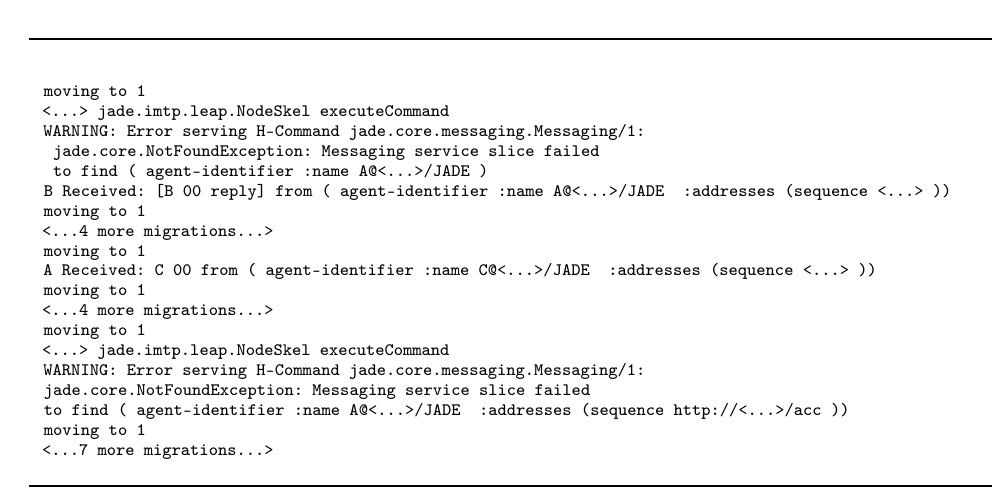
Figure 10. A snippet of the output on Node 0 in the “mobility” scenario, where Jade fails to deliver messages to a fast-migrating agent. Every time the agent is migrating, it is moving to the next node—Node 1.